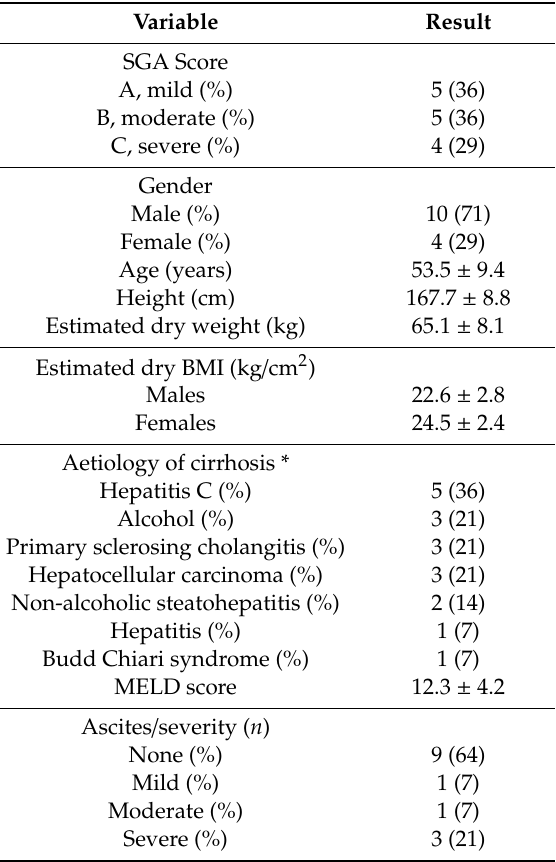
Table 1. Demographic data of 14 participants.